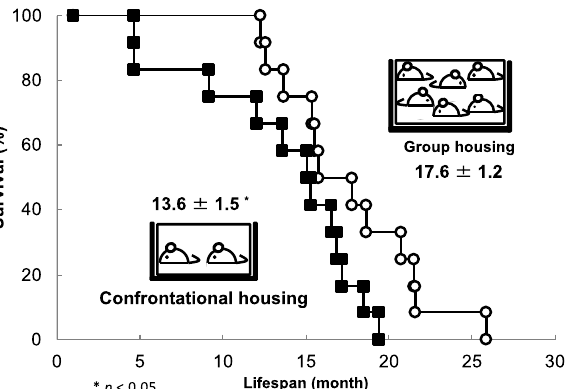
Figure 6. The effect of confrontational housing on the lifespan of SAMP10 mice. Mice were housed alone for one month before confrontational housing conditions were induced. Mice that died early were observed, and the maximum survival time was approximately 20 months (closed square). In contrast, group-housed control mice began to die at around 12 months of age, with a maximum survival time of 26 months (open circles) (n = 12) [77].